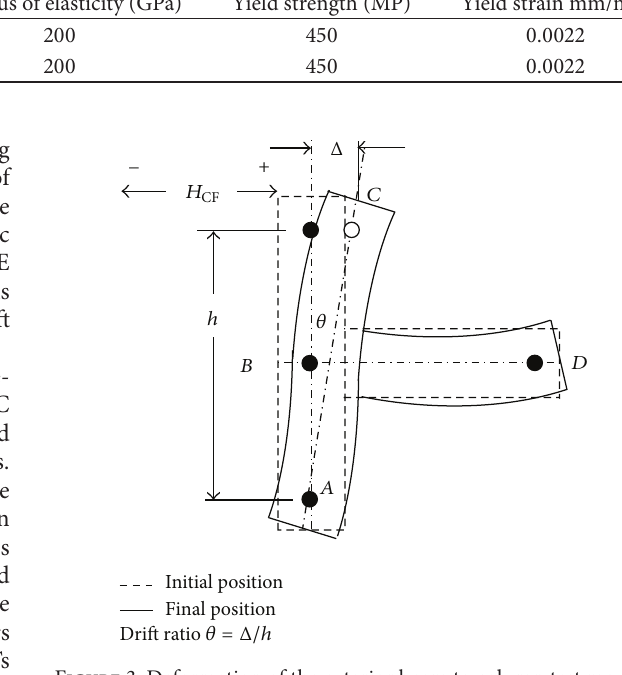
Figure 3: Deformation of the exterior beam to column test module